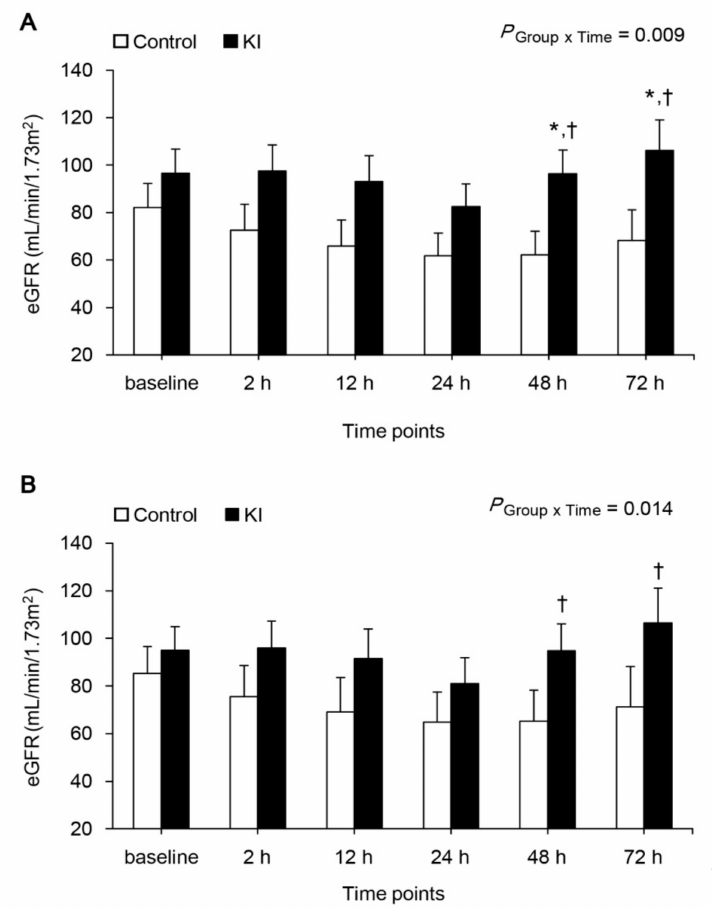
Figure 2. eGFR. ( A ) not corrected and ( B ) corrected by ischemia time and mass size. * p < 0.05